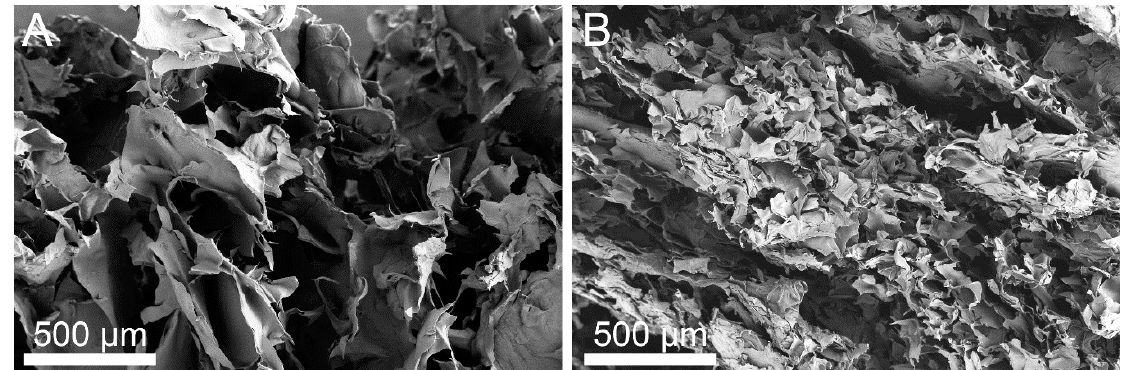
Figure 5. SEM images of the loaded chitosan-based hydrogels: ( A ) Xr and ( B ) Non-Xr.